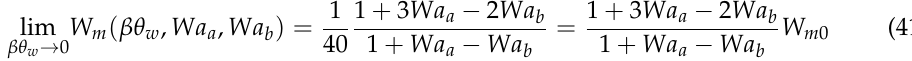
Figure 6. Effect of van der Waals number Wa b on the normalized Nusselt number under condition Wa a = const. 1— Wa a = 0, 2— Wa a = 0.1, 3— Wa a = 0.2.